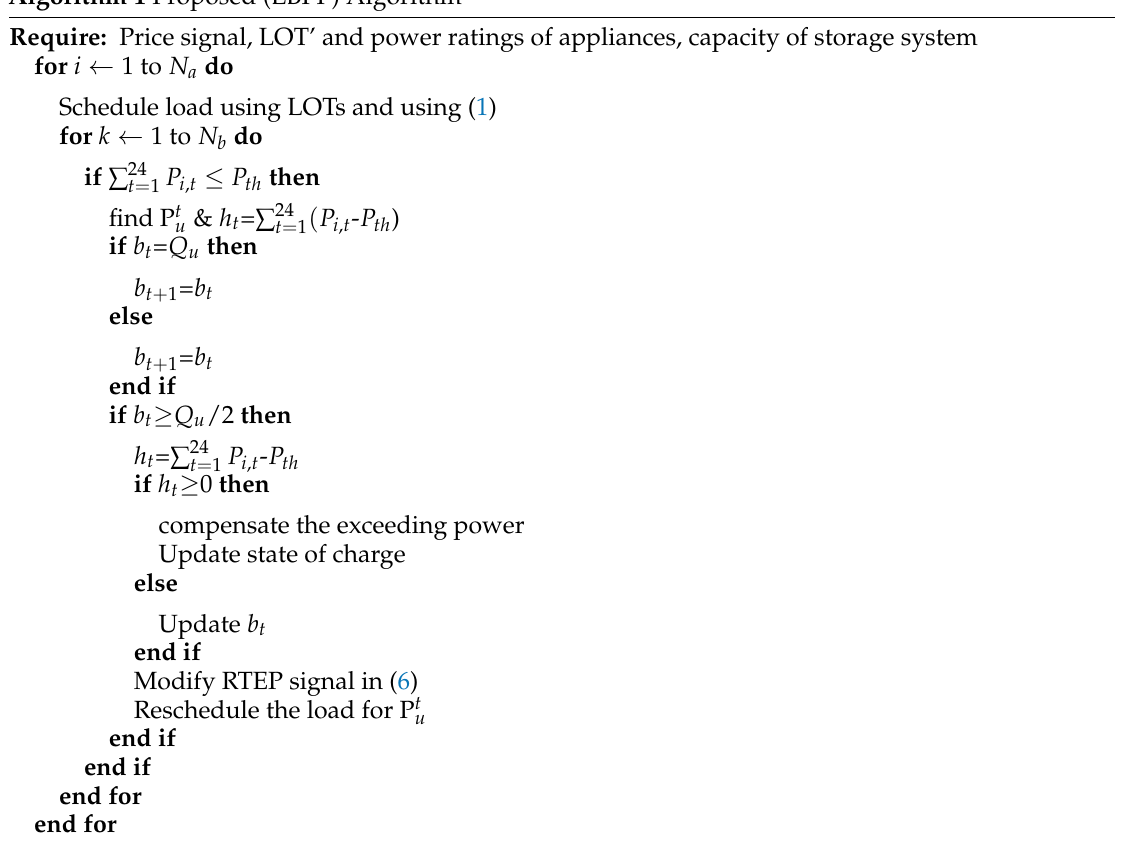
Algorithm 1 Proposed (LBPP)